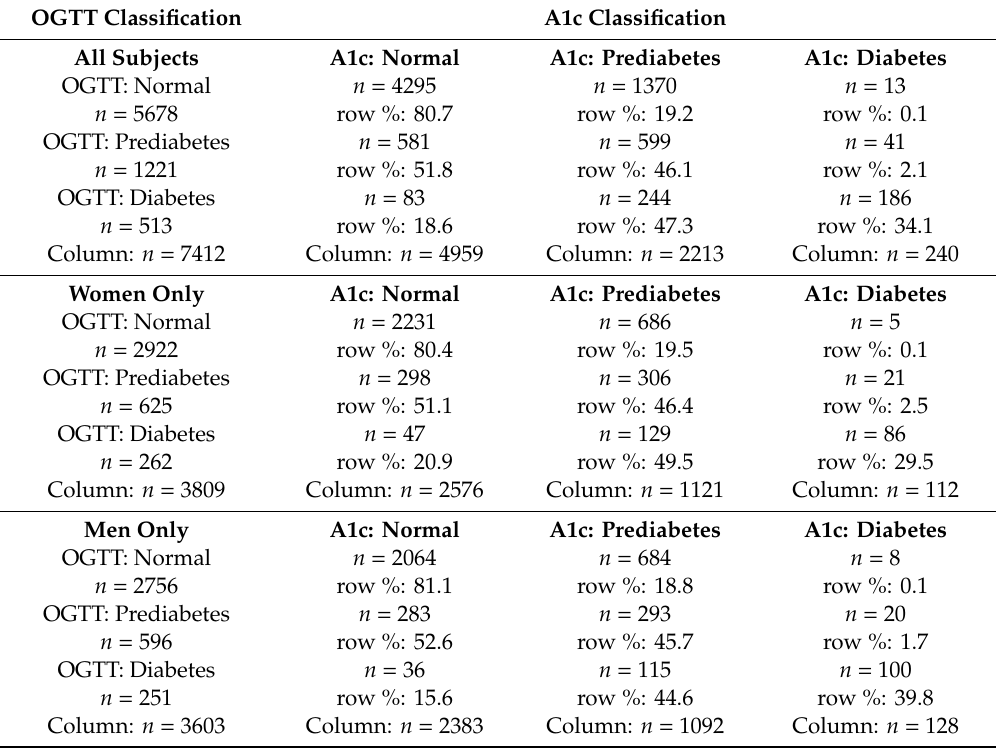
Table 2. Agreement between test results for the Oral glucose tolerance test (OGTT) and the hemoglobin test (A1c) in U.S. women and men analyzed separately and combined, 2009–2016. OGTT